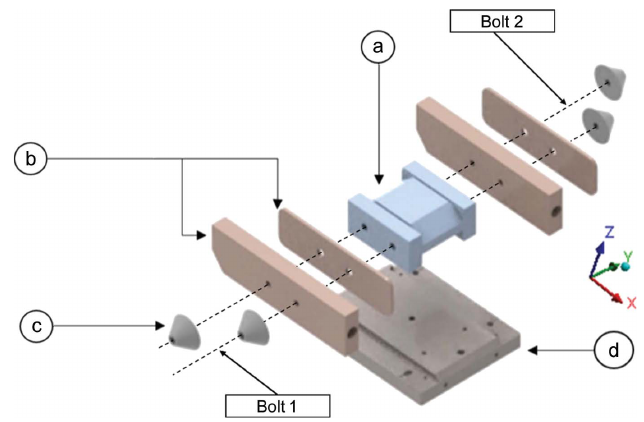
Figure 1 Exploded view of the monochromator assembly with ( a ) a silicon crystal, ( b ) copper cooling blocks with side panels, ( c ) cones to ensure even distribution of clamping force and ( d ) a base plate. The assembly is clamped with bolts using the through holes. The bolt locations are represented by dashed